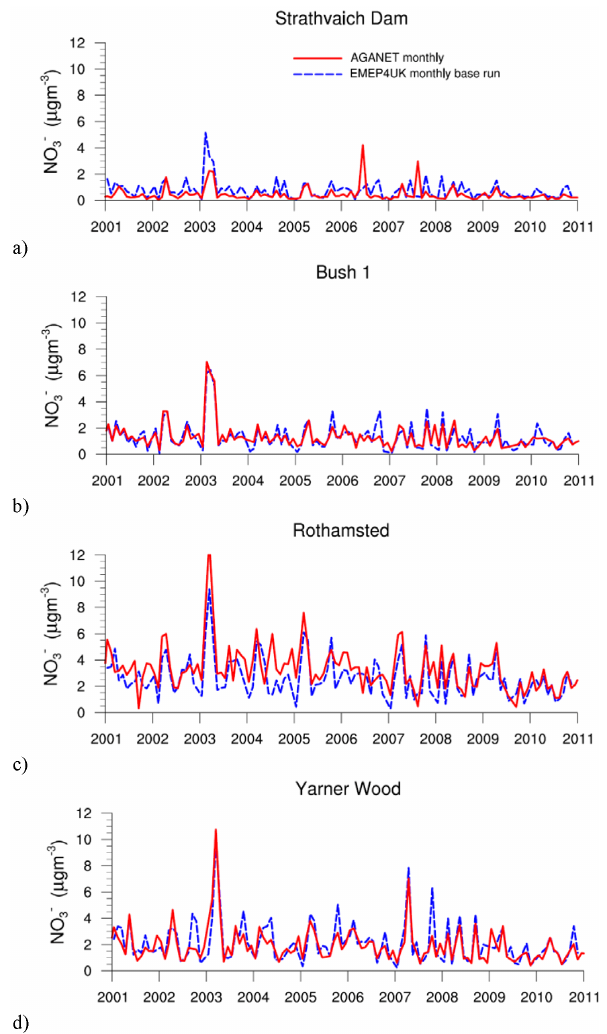
Figure 3. Monthly average surface concentration of particulate mat- ter sulfate, observed (red) and modelled (blue), for 2001–2010 at four sites of the AGANet network: Strathvaich Dam (northwest Scotland), Bush (central Scotland), Rothamsted (southeast Eng- land), and Yarner Wood (southwest